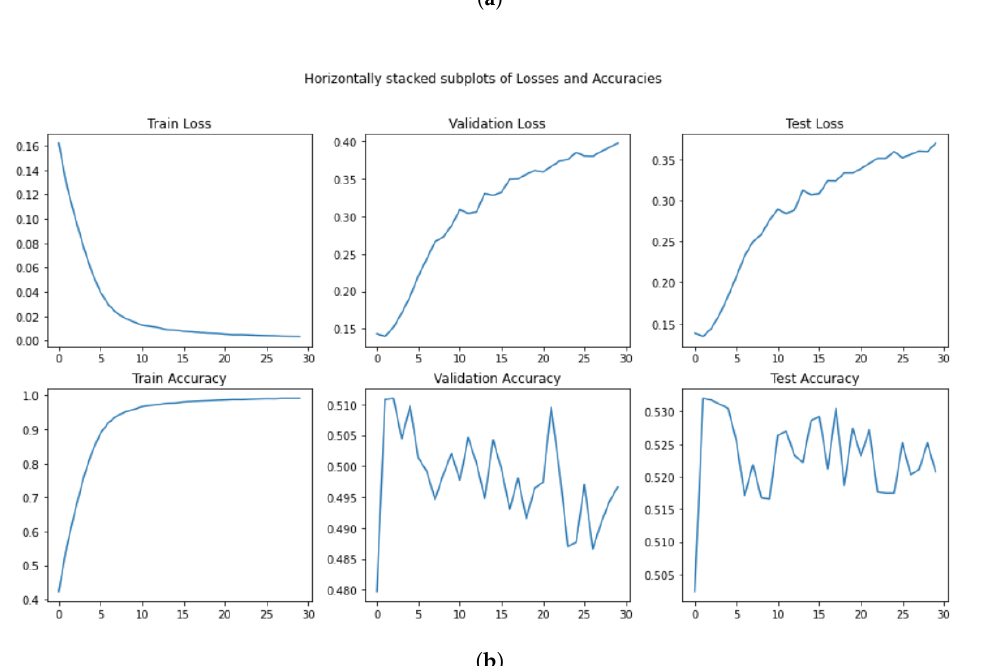
Figure 7. Performance in the training, validation, and test set for BERT BASE . ( a ) Loss and Accuracy per run and per epoch. ( b ) Mean loss and mean Accuracy per